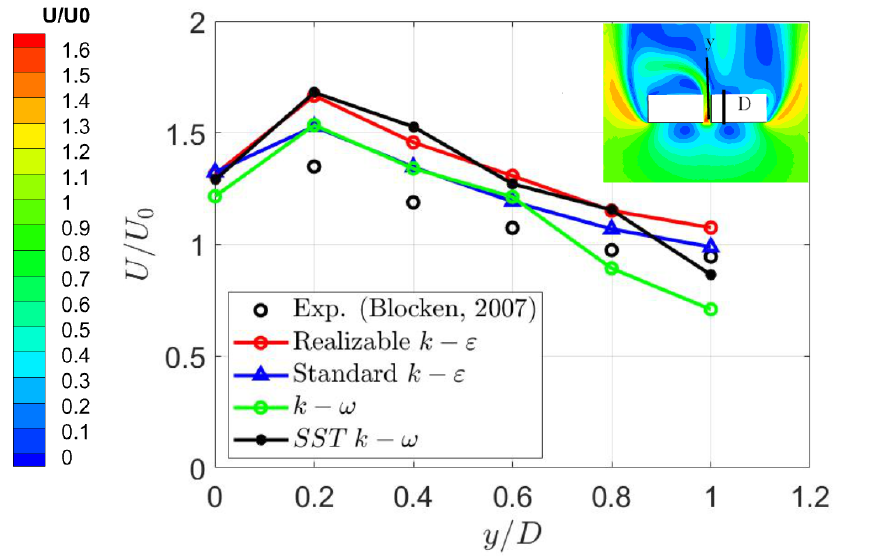
Figure 5. Comparison of amplification factors (u/u 0 ): u 0 : 5.9 (m/s) using different turbulence model (same cell size); building width: 6